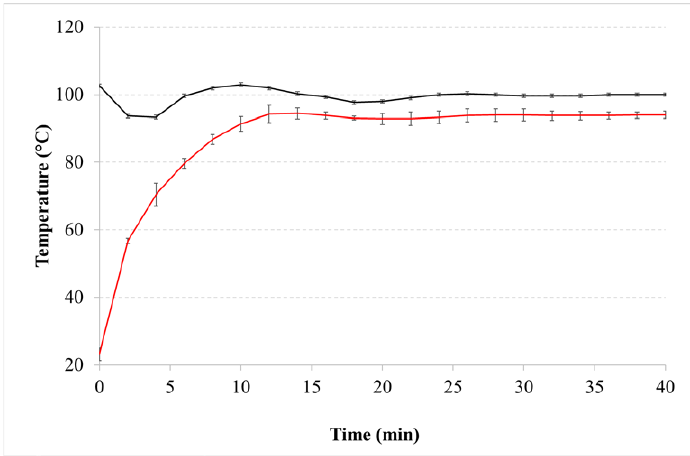
Figure 1. Temperature variation of olive oil (red line) and silicone oil (black line) over time during Figure 1. maceration.